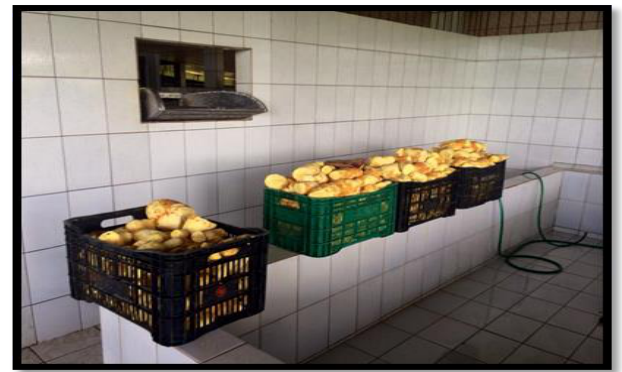
Figura 3: Área de descascamento de matéria-prima.